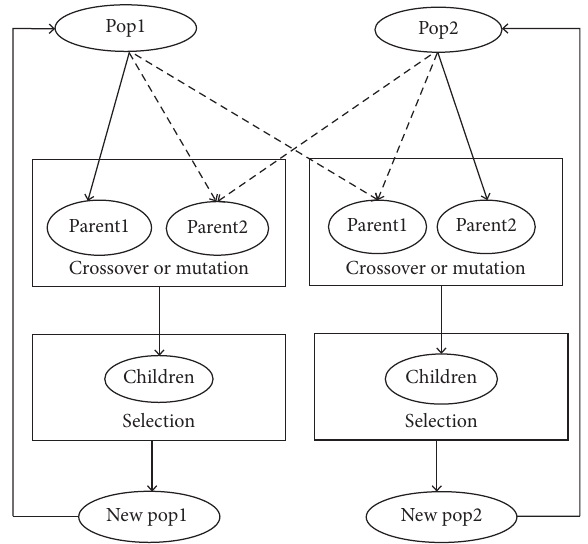
Figure 1: Model of multipopulation evolution for two